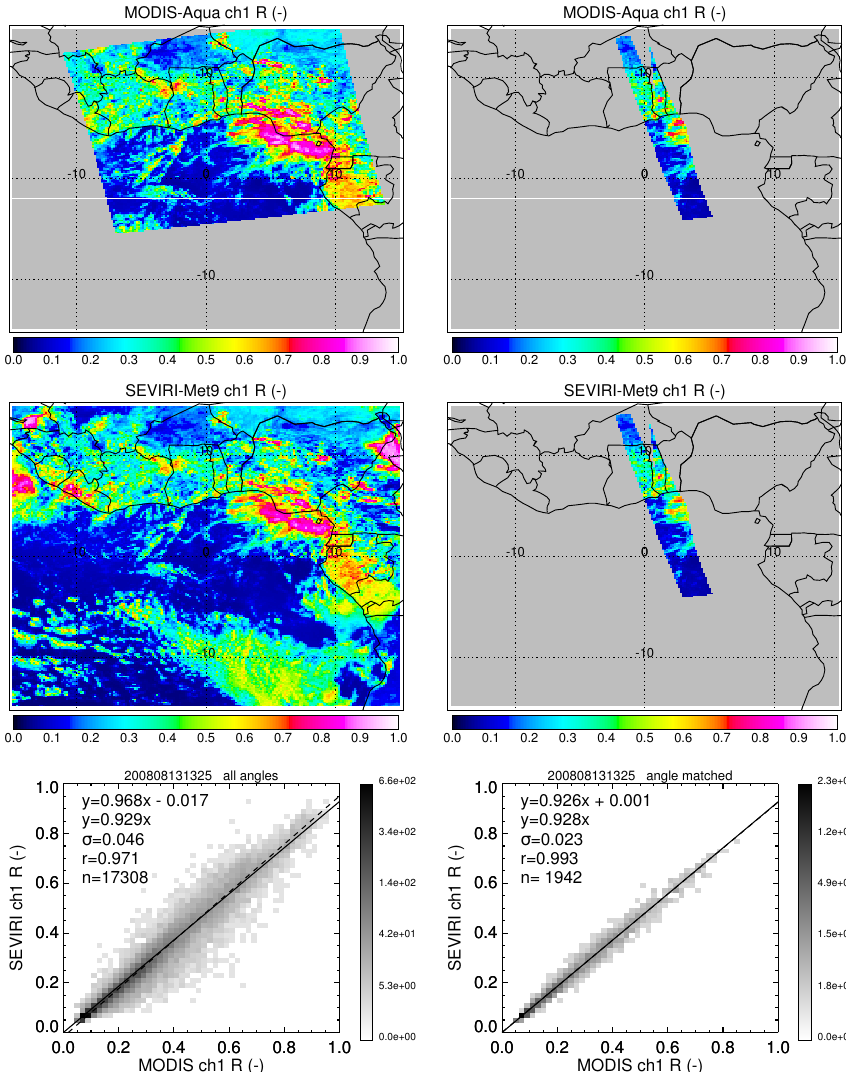
Fig. 3. Illustration of the calibration approach for a MODIS-Aqua granule on 13 August 2008 between 13:25 and 13:30UTC and a SEVIRI image around 13:21UTC. The top row shows MODIS ch1 reflectance, and the middle row shows SEVIRI ch1 reflectance corrected to the MODIS SRF using Eq. ( 7). The bottom row shows scatter density plots between SEVIRI and MODIS R in which the free linear fit (dashed) and the linear fit through the origin (solid) are indicated. A cubic colour scale, as indicated by the vertical bars, has been used to make the low densities visible. Fit statistics including the standard deviation relative to the fit line ( σ ), the Pearson correlation coefficient ( r ), and the number of grid cells ( n ) are listed. The left panels are for all available data, while the right panels are restricted to those grid cells satisfying the standard geometric selection